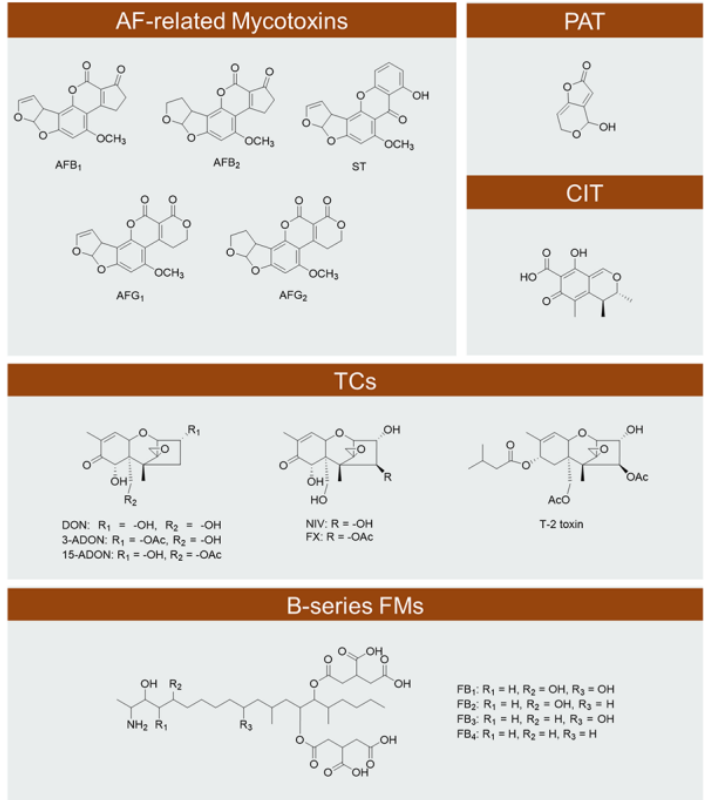
Figure 1. The most critical mycotoxins in food industry.